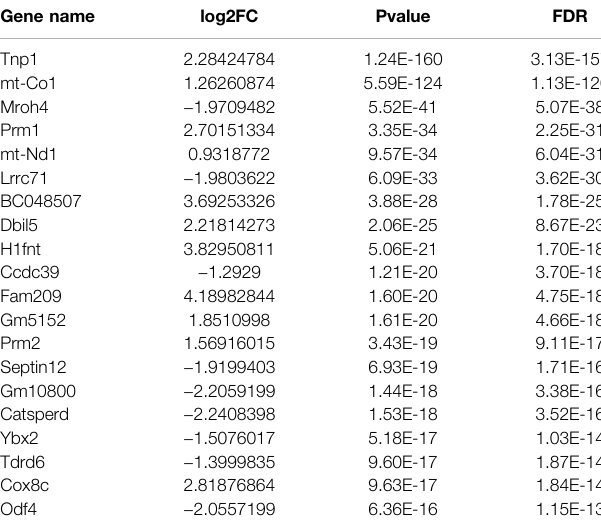
TABLE 1 | The top 20 differential protein-coding genes in Alkbh5 -KO PA and WT PA. Gene name